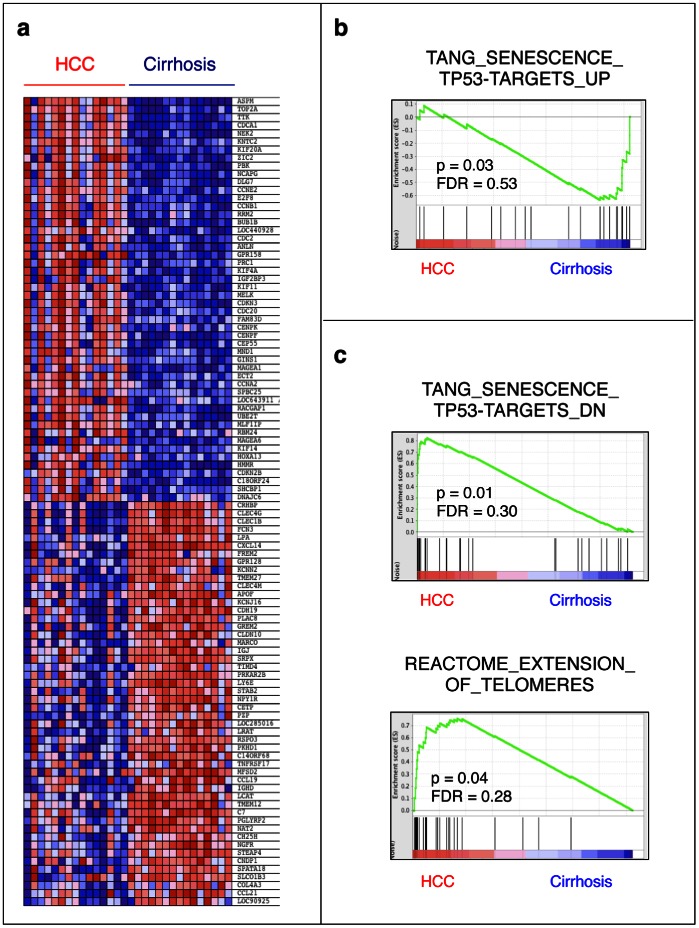
Gene expression profile analysis by gene set enrichment analysis (GSEA) revealed the overexpression of senescence-upregulated genes in cirrhosis, but over-expression of senescence-downregulated genes and telomere extension genes in HCC tissues.(a) Heat map representation of the top 100 deregulated genes in hepatocellular carcinoma (HCC) versus cirrhosis samples. Red: up-regulated; blue: down-regulated. Previously identified gene sets (available at molecular signature database (MSigDB; www.broadinstitute.org/gsea/) were screened to identify those that are up-regulated in cirrhosis or HCC tissues by the analysis of their relative expression levels using GSEA method. (b) Enrichment plot of p53-responsive genes up-regulated during replicative senescence arrest (“TANG_SENESCENCE_TP53_TARGERTS_UP”) [41] showing over-expression in cirrhosis. (b) In contrast, p53-responsive genes down-regulated during replicative senescence arrest (“TANG_SENESCENCE_TP53_TARGERTS_DN”) [41] and those involved in telomere extension (“REACTOME_EXTENSION_OF_TELOMERES”; www.reactome.org) were overexpressed in HCC tumors. Enrichment scores (ES) are shown on the y-axis. Positive and negative ES indicate enrichment in HCC and cirrhosis samples, respectively. X-axis bars represent individual genes of the indicated gene sets. FDR: False discovery rate, p: nominal p-value. Fifteen cirrhosis and fifteen HCC samples were analyzed for genome-wide gene expression using Affymetrix 54 K microarrays and normalized data were used for gene set enrichment analysis (GSEA).